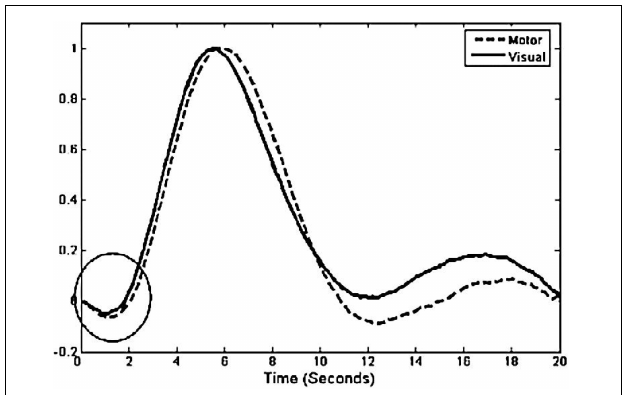
FIGURE 1 | HRF experience curve (Mosso,